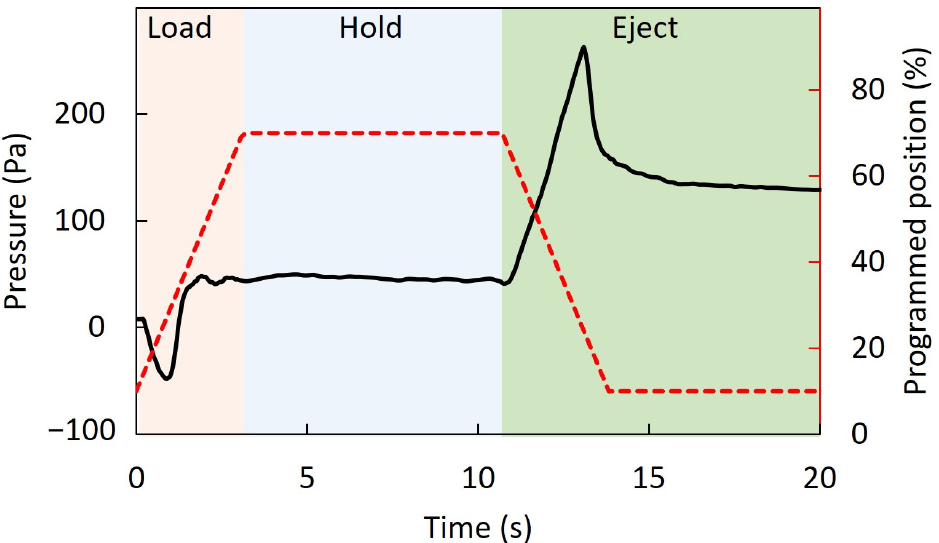
Figure 6. Dynamic pressures (left axis) generated by a prototype standardized artificial insemination device (SAID) during loading, holding, and ejecting of 5 µ L water samples. Programmed actuator position is shown on the right axis.